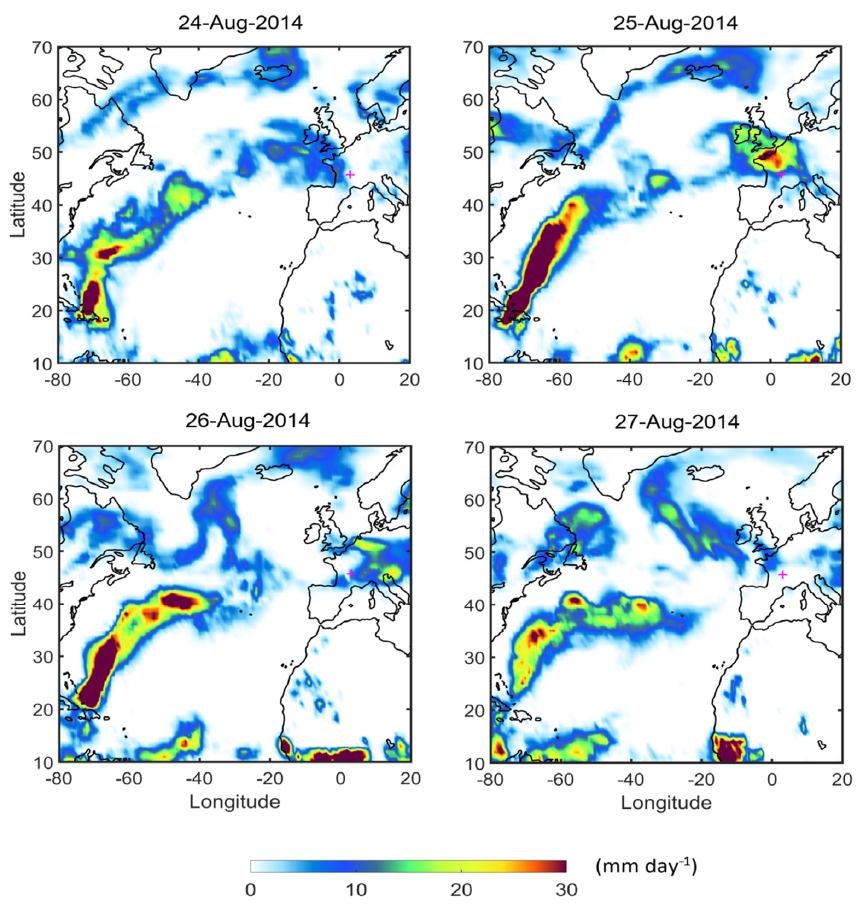
Figure 9. Daily precipitation estimates from GPCP v1.3 from 24 ( top left ) to 27 August 2014 ( bottom right ). The location of Clermont-Ferrand is marked by a pink cross.